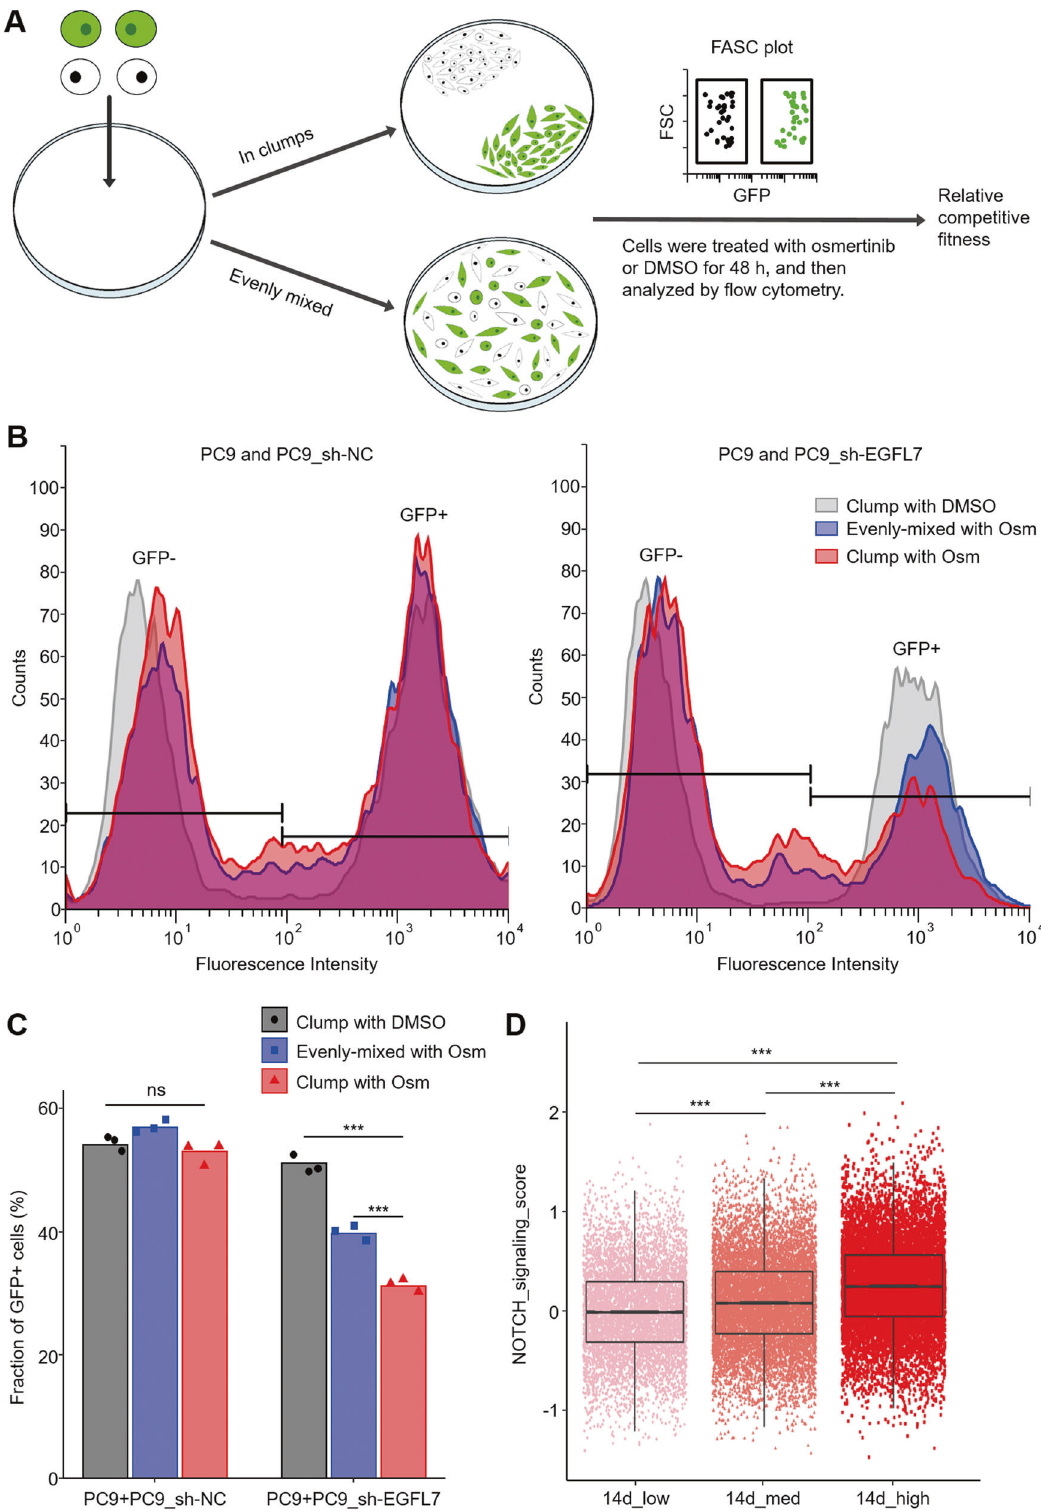
Fig. 5 EGFL7 activates NOTCH signaling extracellularly. A Schematic of experimental work fl ow for cell competition assay to access the relative fi tness in osimertinib (Osm) exposure. B FACS plot presenting cell number across different fl uorescence intensity in the mixture of PC9 cells and EGFL7-knockdown PC9 cells (right panel) or control cells (PC9_ sh-NC, left panel). C Bar plot presenting the statistic results from B . D Boxplot presenting NOTCH signaling scores in low, medium and high mCherry expression PC9 subgroups with a 14-day osimertinib treatment (GSE150949, N = 26,990, see methods). FACS indicates fl uorescent-activated cell sorting. p values are calculated by one-way ANNOVA with Tukey multiple comparisons (ns, p > 0.05; *** p < 0.001).